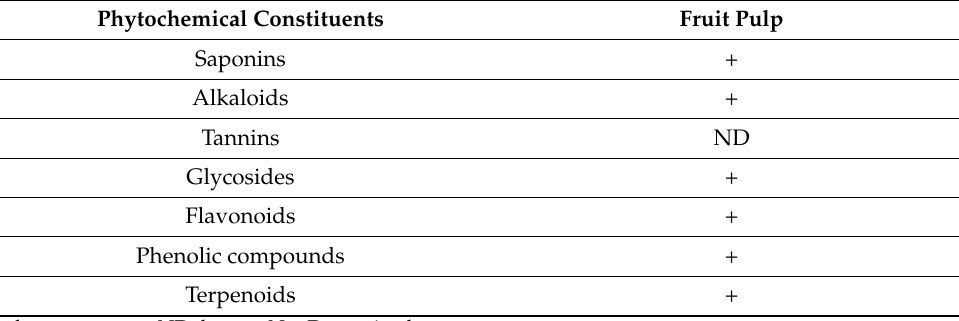
Table 3. Phytochemical screening of Ajwa date ethanolic